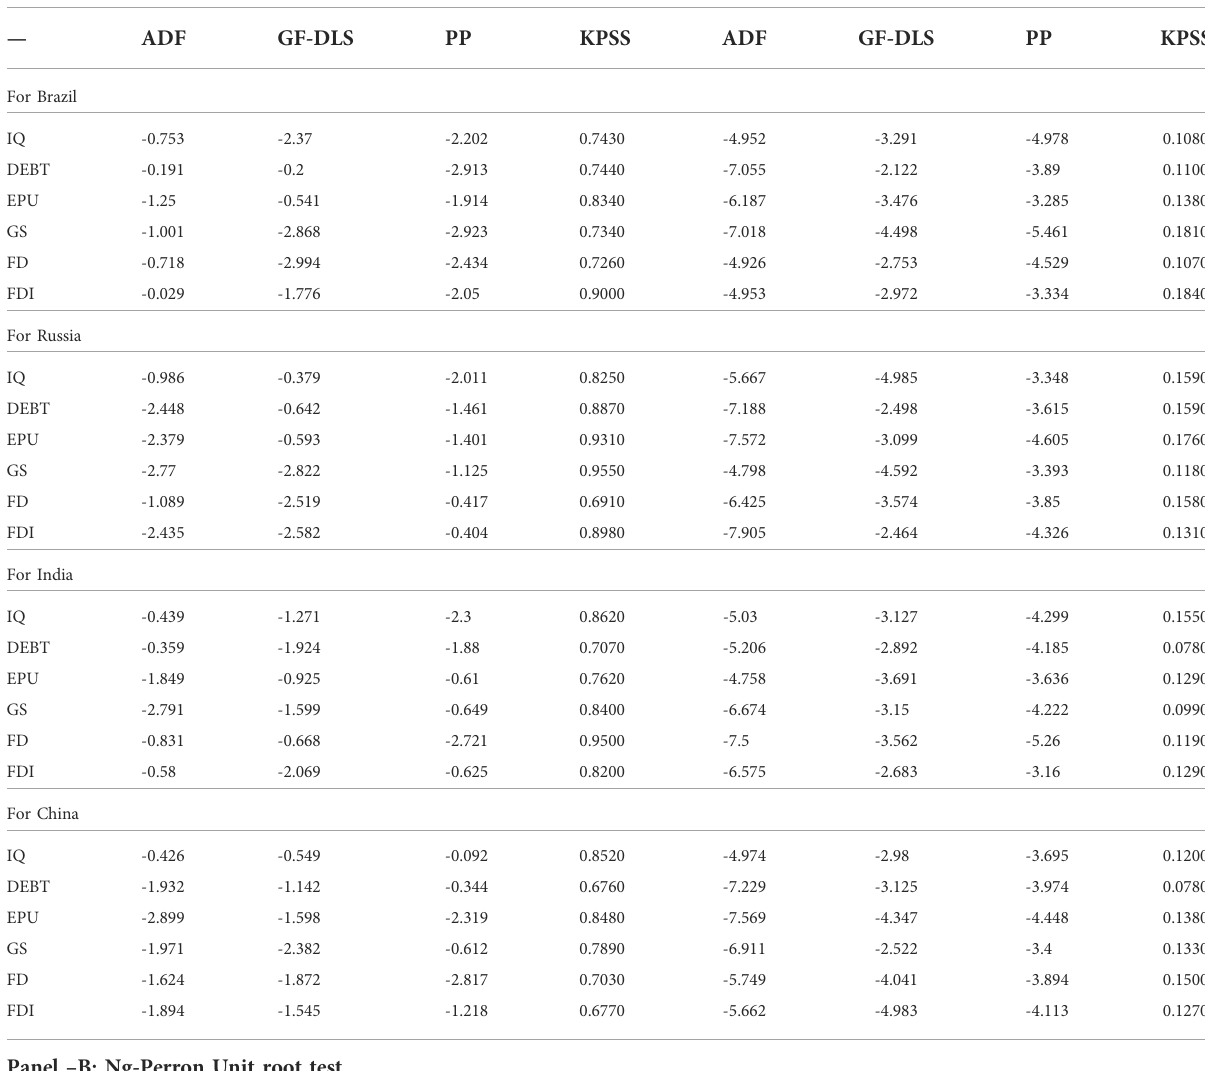
TABLE 3 Unit root